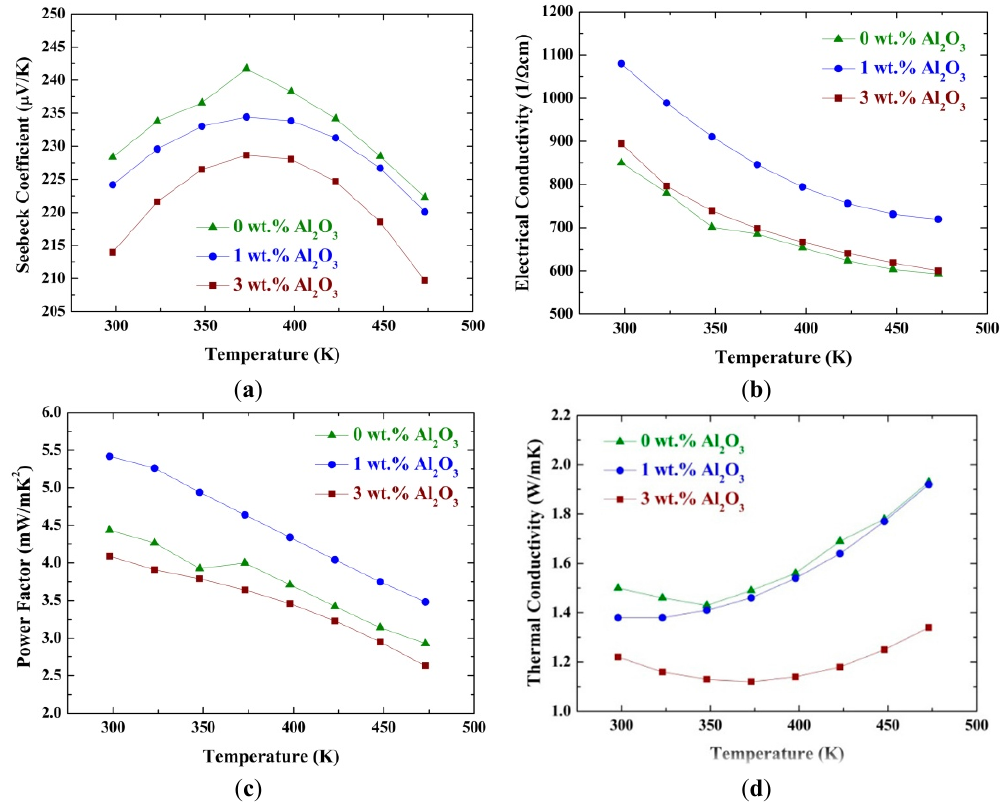
Figure 5. Temperature dependence of the TE properties for the γ -Al 2 O 3 /Bi 0.4 Sb 1.6 Te 3 specimens: ( a ) Seebeck coefficient; ( b ) electrical resistivity; ( c ) PF; and ( d ) thermal conductivity. The variation of ZT as a function of temperature for the γ -Al 2 O 3 /Bi 0.4 Sb 1.6 Te 3 bulk specimens is shown in Figure 6.